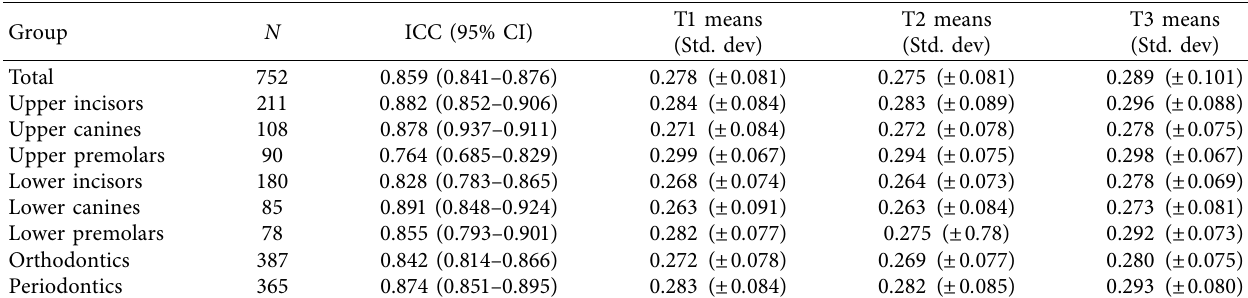
Table 4: Intrarater ABT by tooth groups and clinic